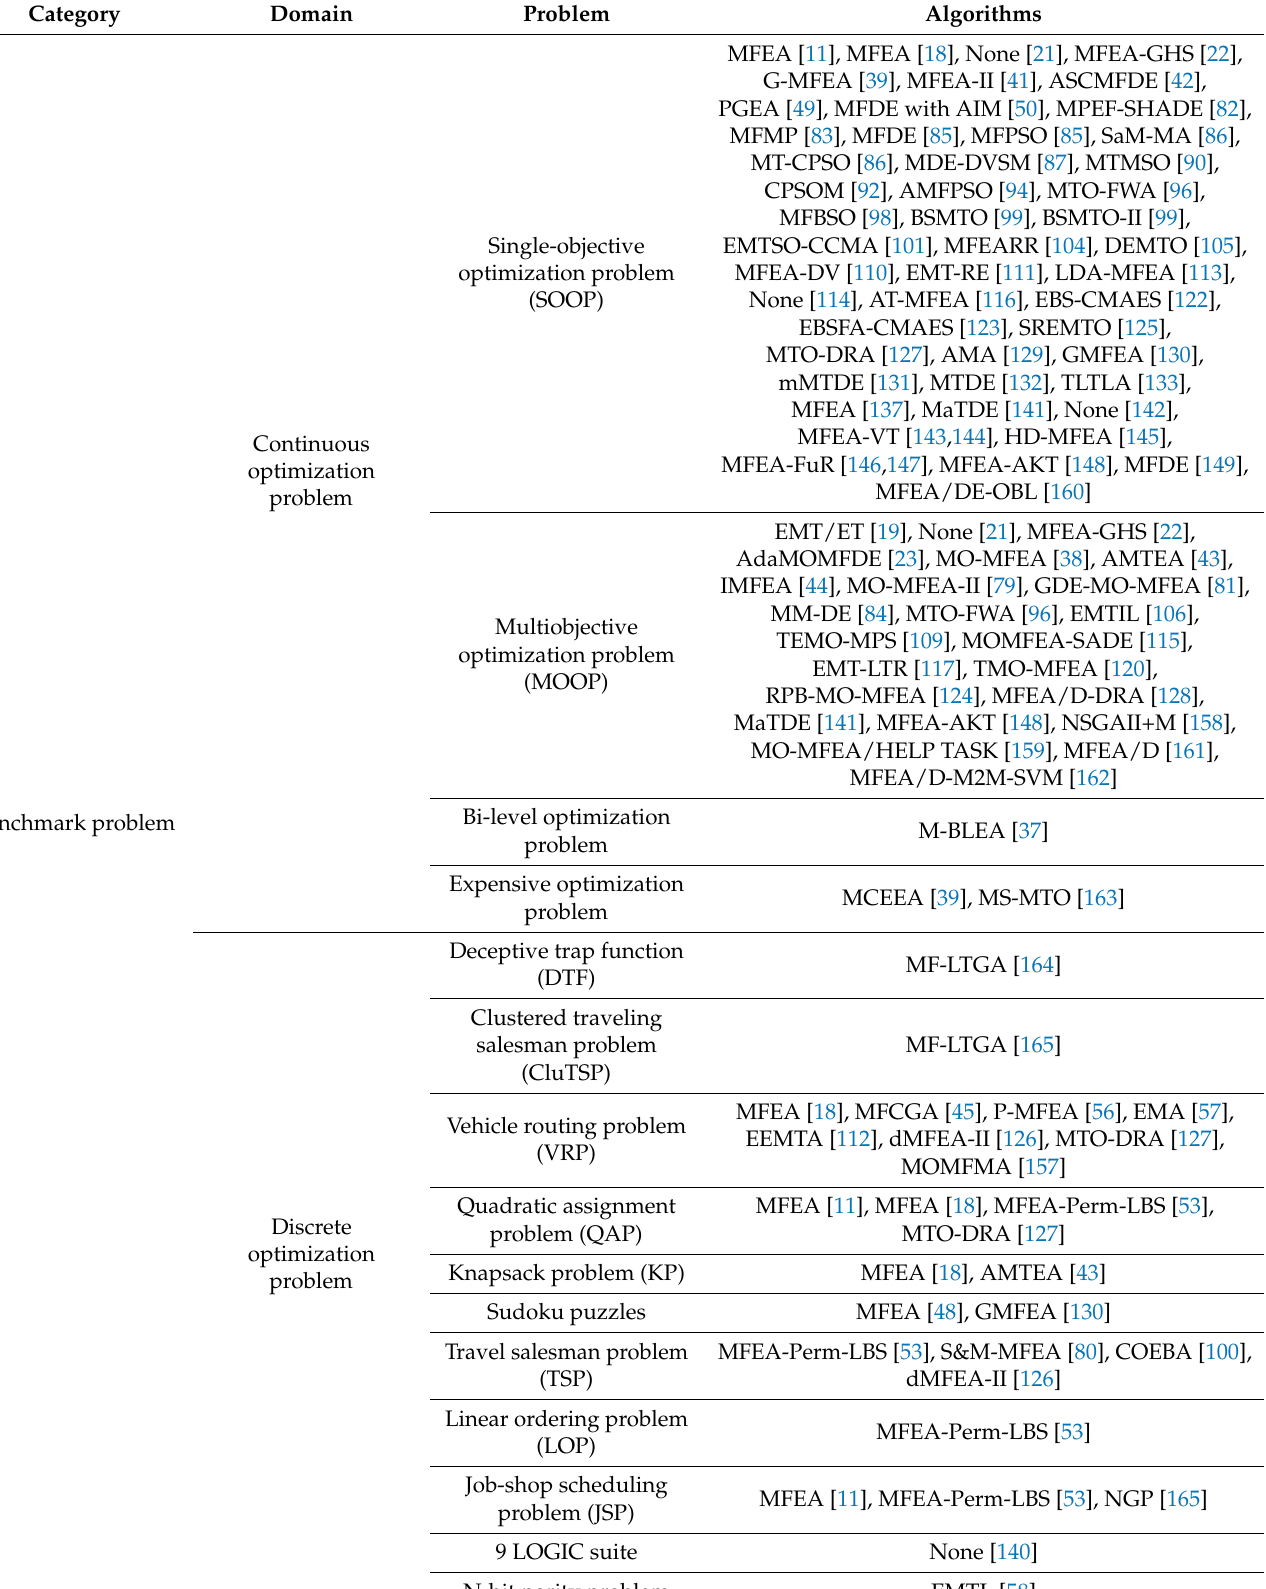
Table 3. Application domains of MTEC algorithms in the past five